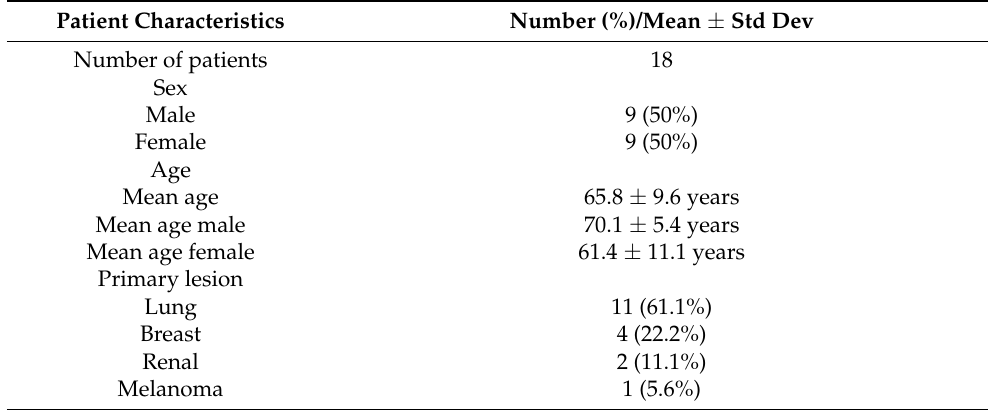
Table 1. Baseline characteristics of